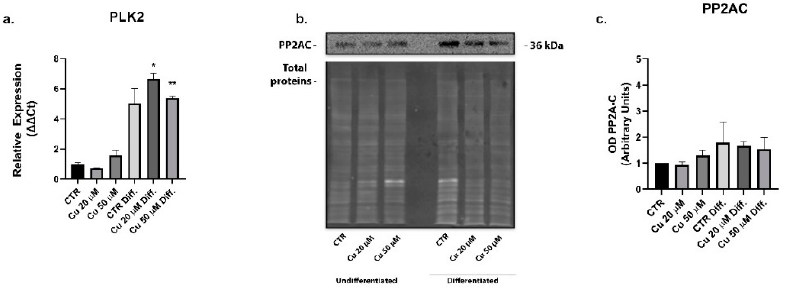
Figure 9. Copper treatment induced the expression of the kinase PLK2 in differentiated SHSY5Y cells. mRNA relative expression of PLK2 in undifferentiated and differentiated cells incubated with 20 or 50 µ M copper ( a ). Representative immunoblots of the phosphatase PP2A ( b ) and densitometric analysis of bands representing means ± SD of three independent experiments ( c ). PP2A values were normalized on total proteins. Values were compared with untreated cells (CTR) by one-way ANOVA following Tukey test * p < 0.0332 ** p < 0.0021.